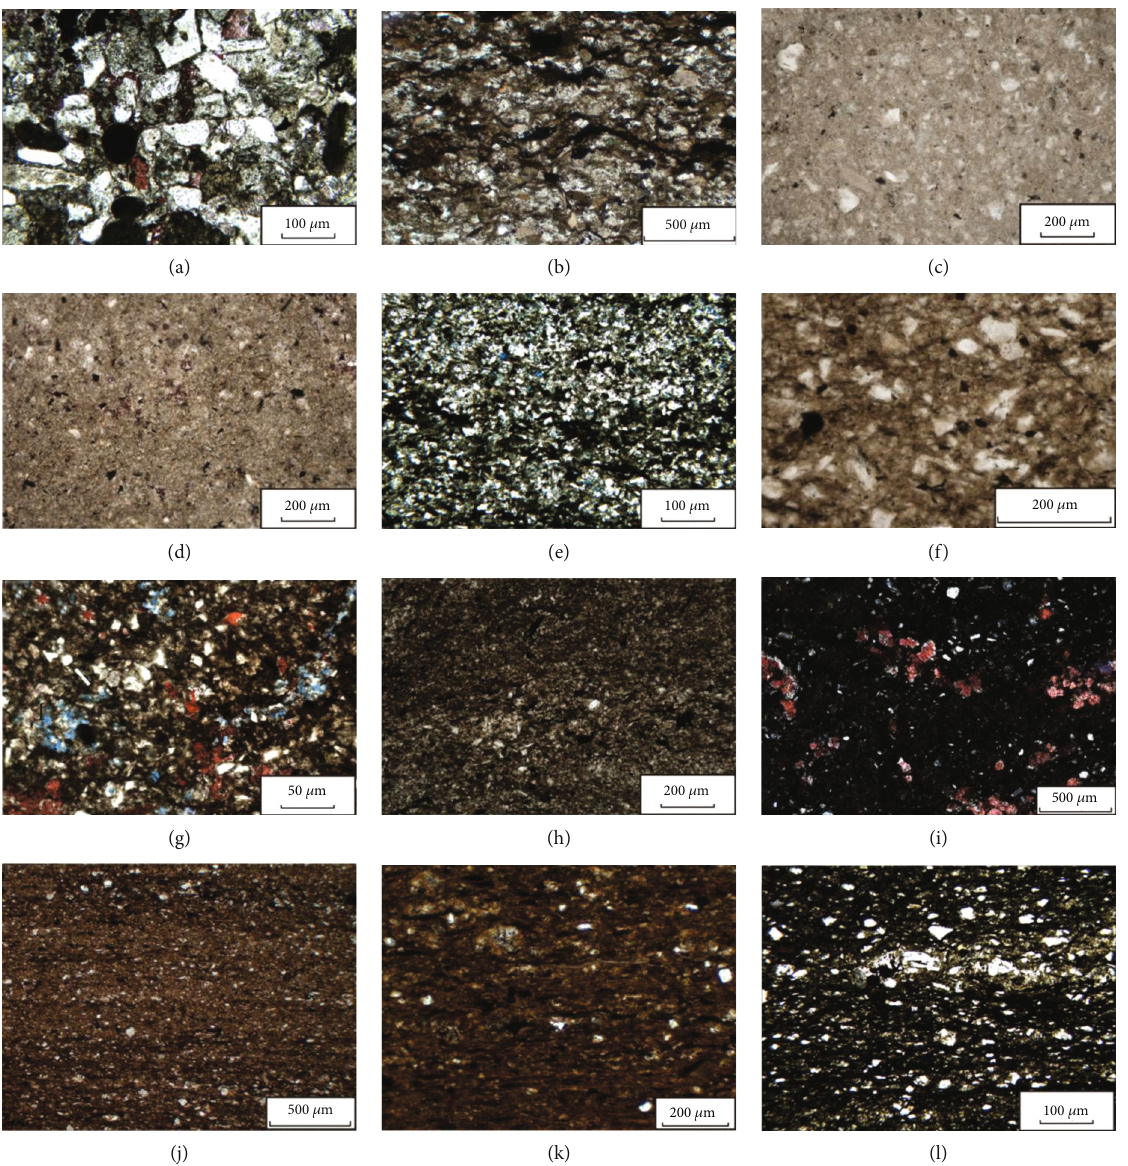
Figure 3: Characteristics of rock types of Lucaogou Formation in Jimsar Sag: (a) very fi ne feldspar lithic sandstone, basalt lithic debris, and other magmatic rock debris (J10005, 2692.55m, P 2 l 2 ); (b) argillaceous siltstone, visible quartz, and feldspar (J10025, 3544.68m, P 2 l 2 ); (c) silty dolomite (J30, 4046.74m, P 2 l 2 ); (d) argillaceous dolomite (J251, 3618.64m, P 2 l 2 ); (e) muddy siltstone, mainly fi ne silt, granular quartz, feldspar mainly plagioclase, and poor particle roundness (J10024, 3631.72m, P 2 l 1 ); (f) dolomite siltstone, dominated by feldspar, subangular (J10024, 3624.52m, P 2 l 1 ); (g) silt-bearing calcareous dolomite, mainly dolomite of a mud-microcrystalline structure with fi ne grains (J10005, 2813.56m, P 2 l 1 ); (h) dolomitic shale, horizontal bedding (J10024, 3636.52m, P 2 l 1 ); (i) calcareous mudstone, organic matter, and clay are mixed together and fi lled between siltstones, and the clay is dyed dark brown and black by organic matter (J10022, 3487.33m, P 2 l 1 ); (j) silty mudstone (J10024, 3619.02m, P 2 l 1 ); (k) dolomitic mudstone, clay is reddish brown by oil and gas disseminated (J10025, 3530.91m, P 2 l 2 ); (l) silty shale, mainly fi ne silt, organic matter, and clay-oriented arrangement and silt interbedded to form layers (J10024, 3484.03m, P 2 l 2